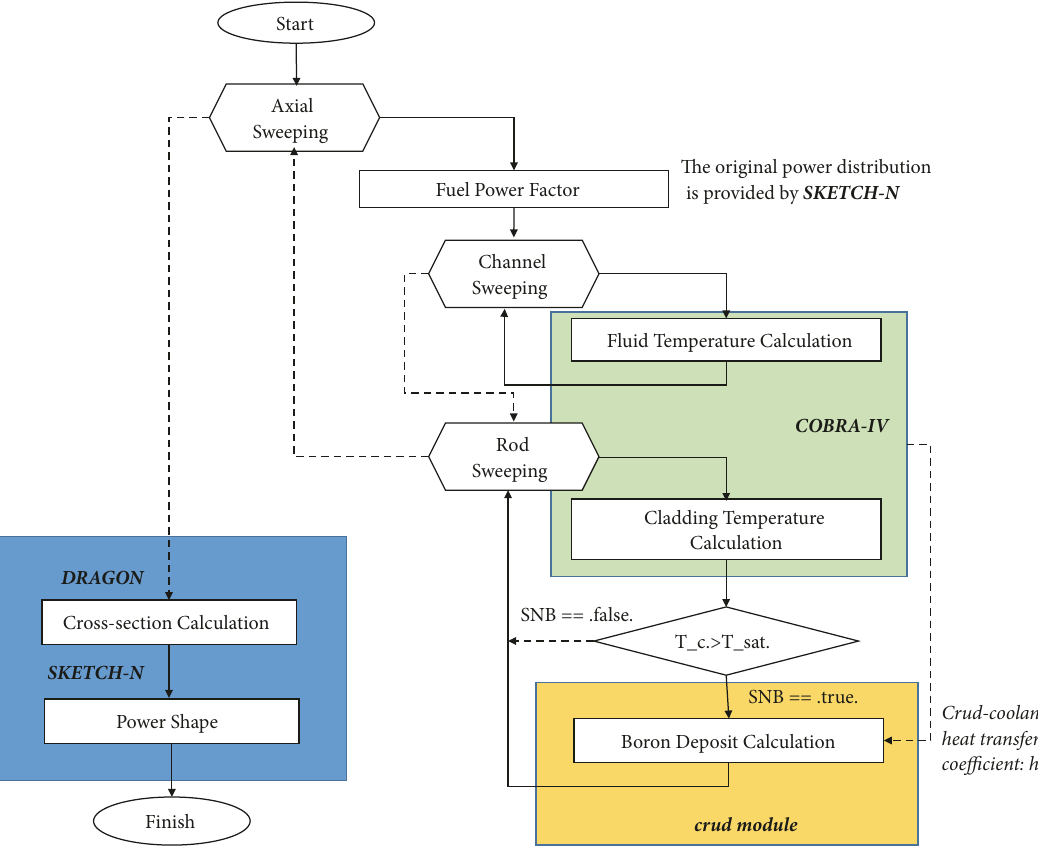
Figure 1: Calculation sequence for CIPS prediction.